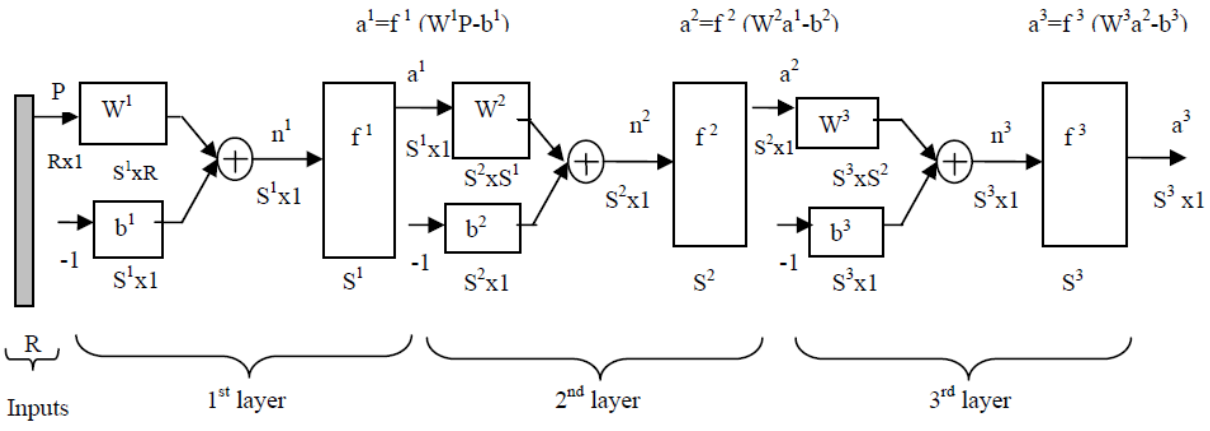
Figure 3. An example of synoptic representation of a 3 layer-neural network in a feed forward back propagation